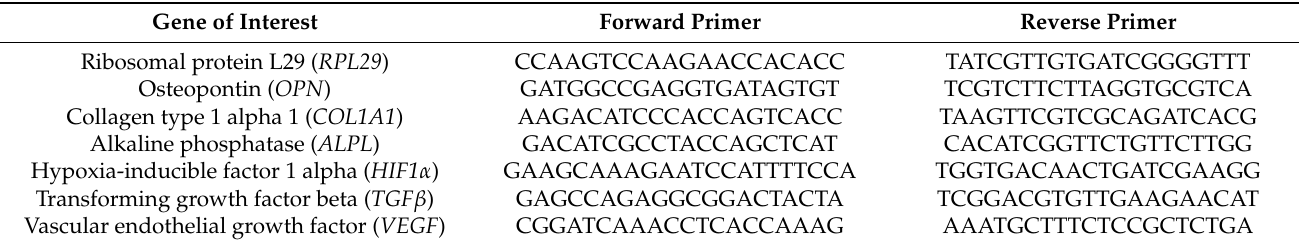
Table 1. Primer sequences used for qRT-PCR